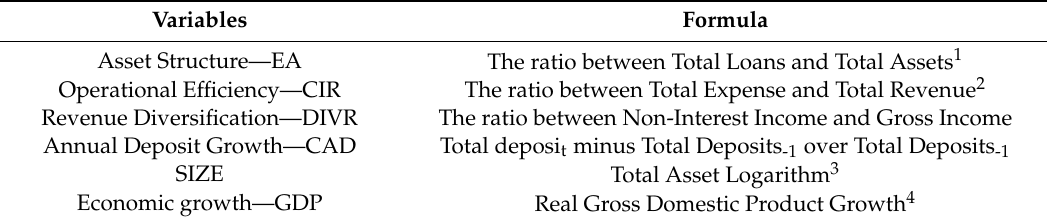
Table 1. Bank-specific and macroeconomic